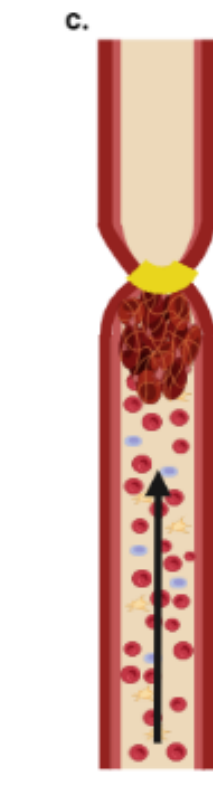
Figure 4. Schematic illustration of stasis and stenosis models. ( a ) Normal blood flow; ( b ) stenosis model—thrombus is formed due to partial block of blood flow; ( c ) stasis model—thrombus is formed due to complete block of blood flow (Created with BioRender.com).